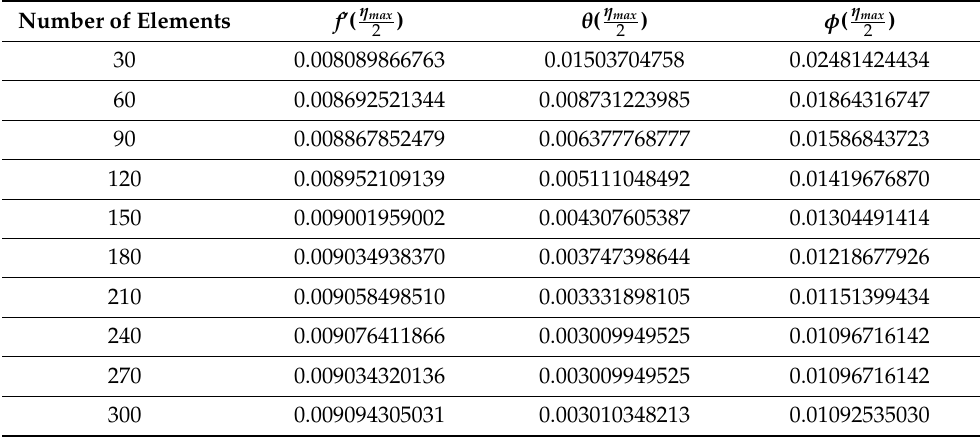
Table 2. Mesh-free analysis of f (cid:48) domain [ 0, 6 ] .